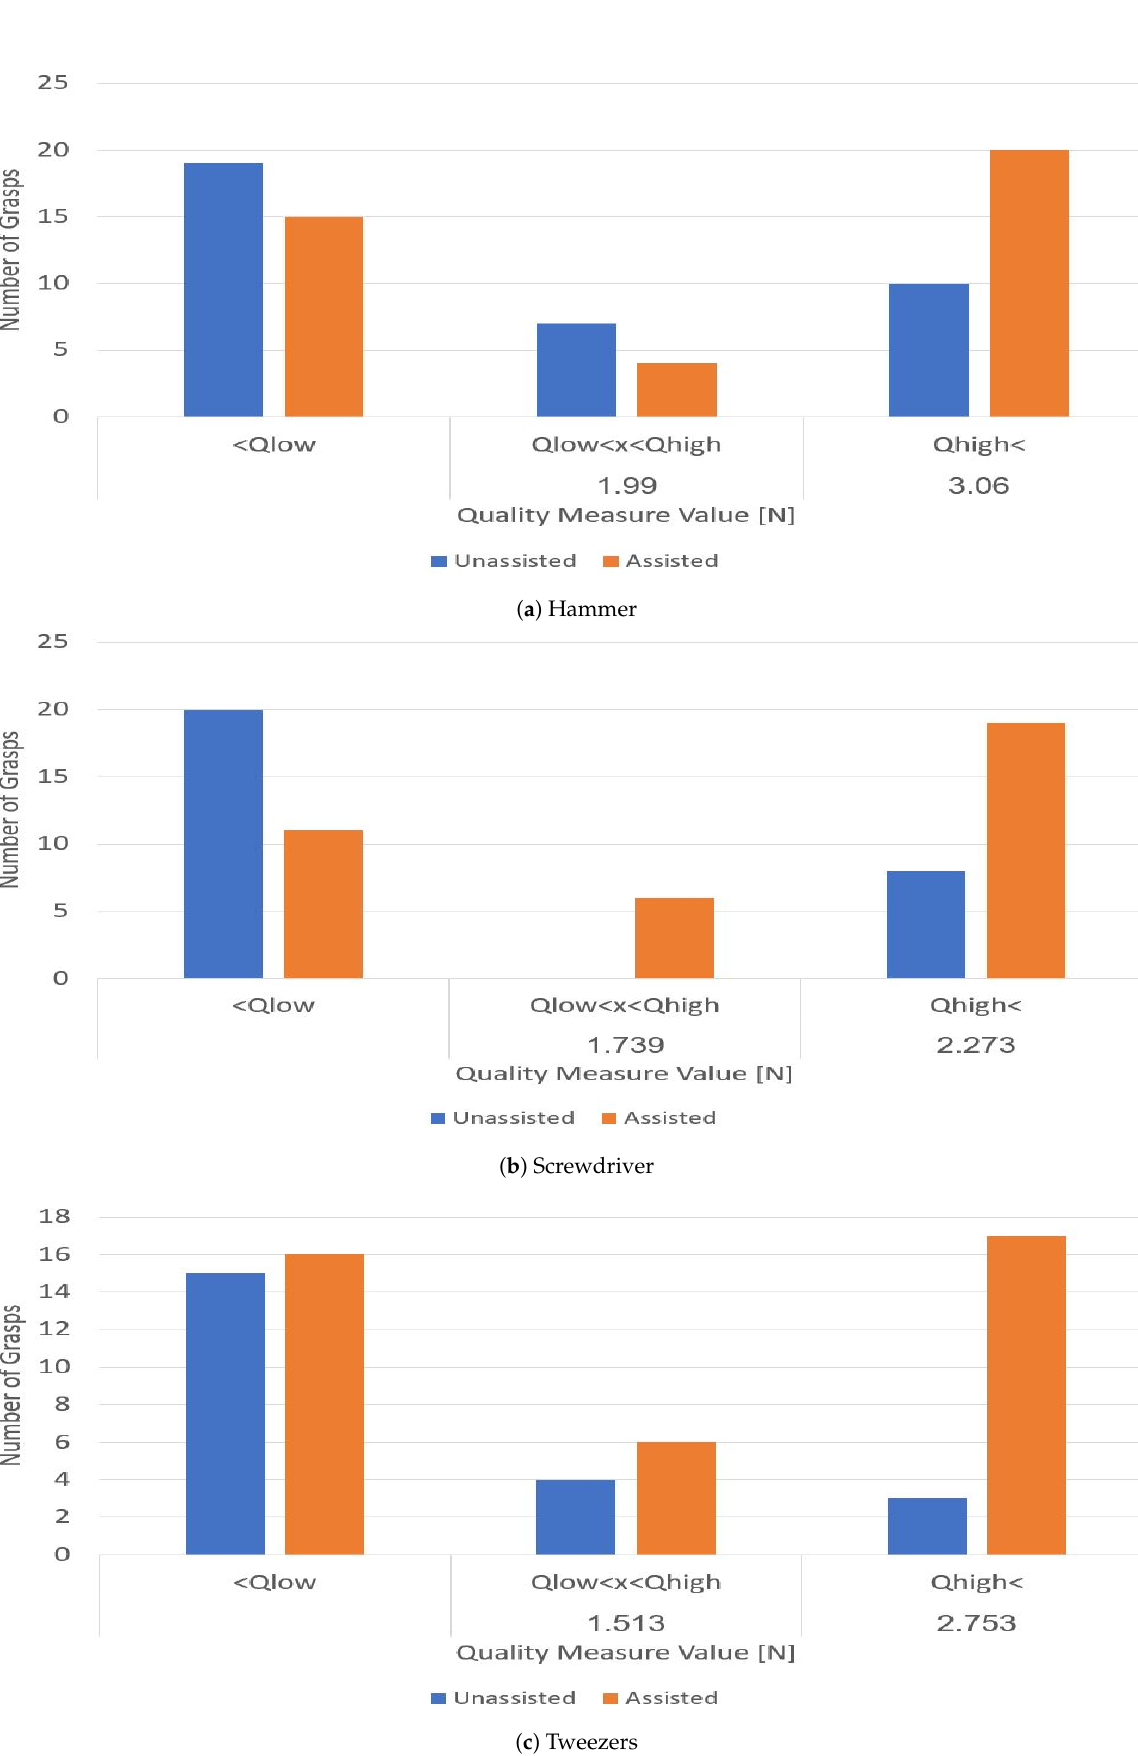
Figure 9. Power grasps comparisons, unassisted and